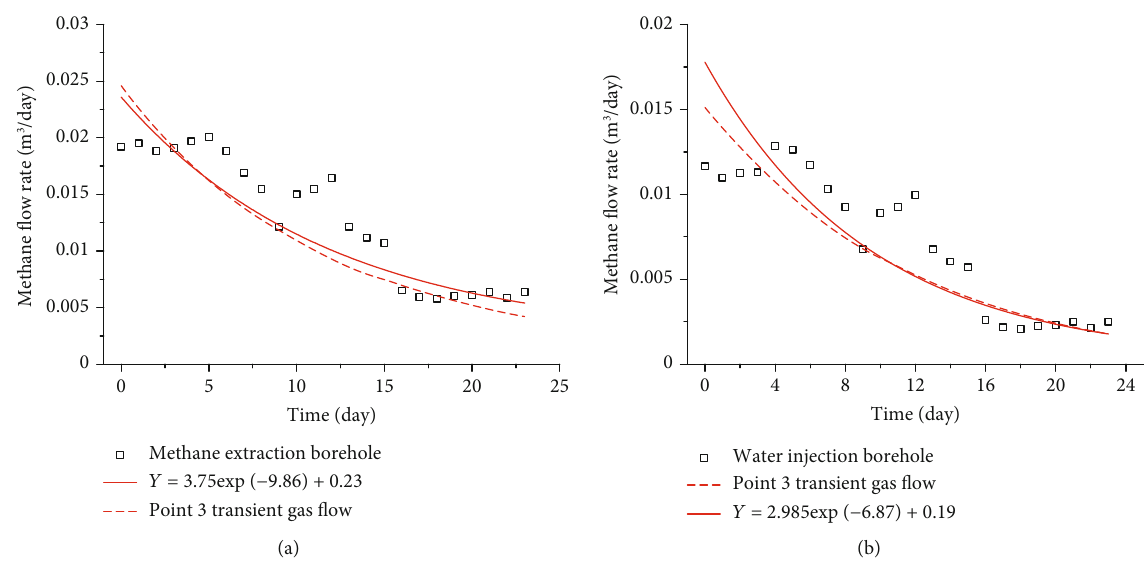
Figure 13: Gas production